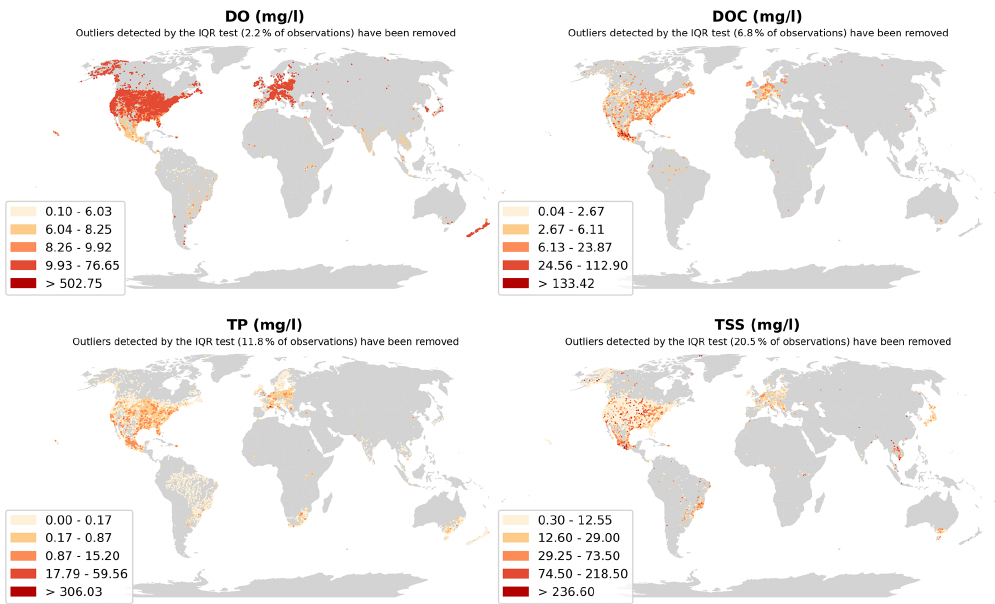
Figure A2. Spatial distribution of yearly median observation values for dissolved oxygen (DO), dissolved organic carbon (DOC), total phosphorus (TP) and total suspended solids (TSSs). Outliers determined by the IQR test are not shown on the plot.